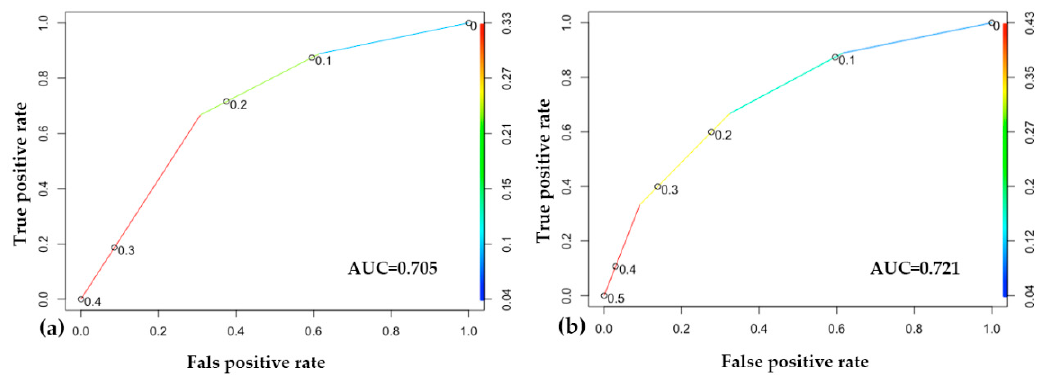
Figure 5. Results of the machine learning approach. ( a ) Receiver operating characteristic (ROC) curve of the original classification-based model; ( b ) ROC curve of the model based on the International Society of Urological Pathology (ISUP) reclassification. In both of the models, at the point (0.6, 0.9), we correctly label about 90% of the cases, with a 60% false positive rate. In the middle, around (0.3, 0.8), we correctly label about 80% of the cases, with a 30% false positive rate.